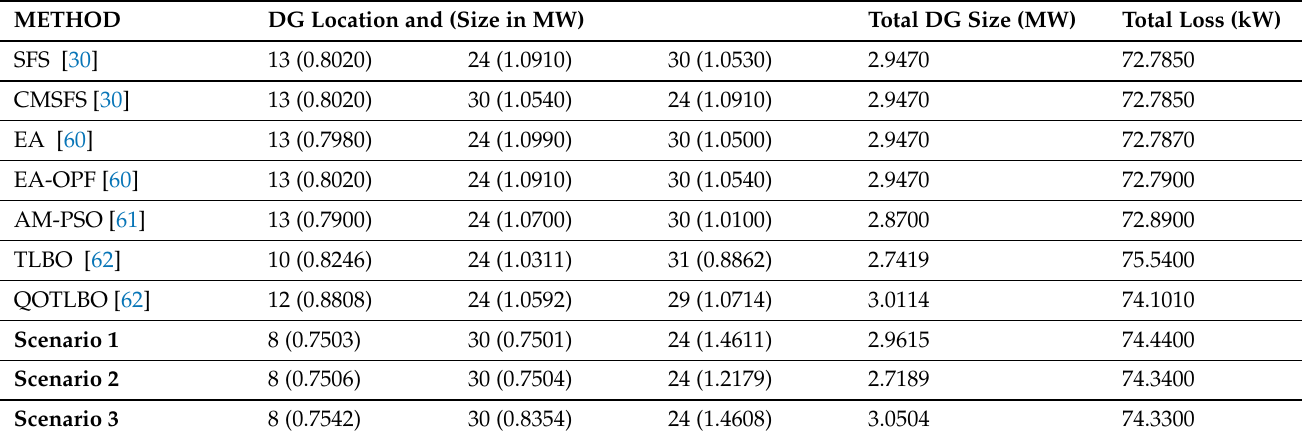
Table 4. Result of comparison with other techniques